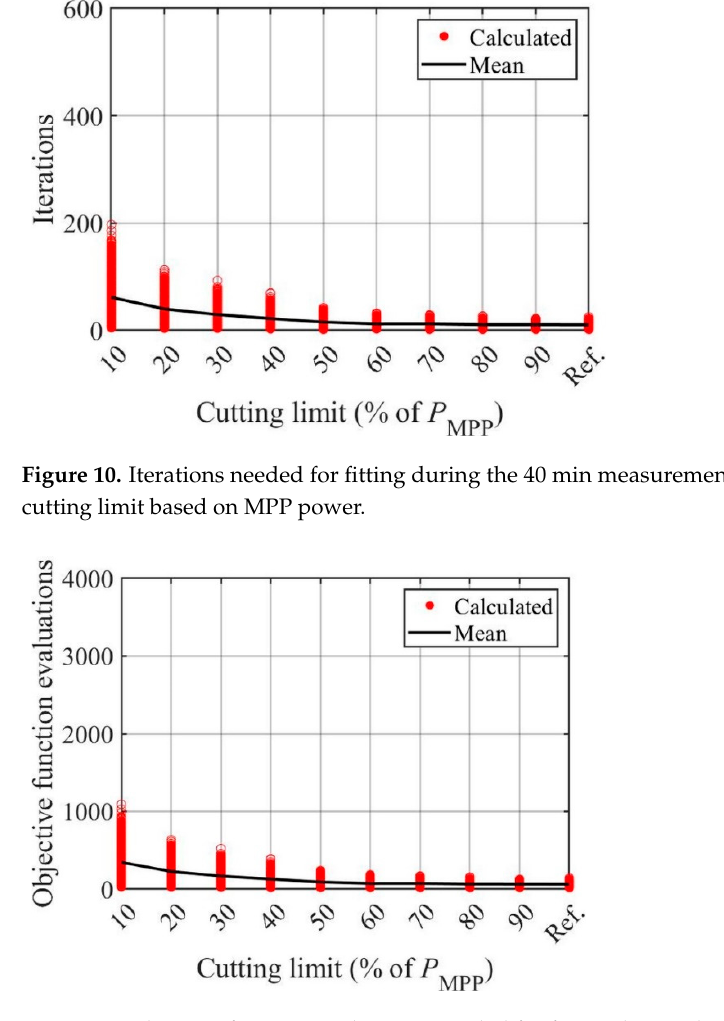
12 of 22 Figure 9. Fitted temperature values during the 40 min measurement period as a function of the cutting limit based on MPP power. Figure 10 shows the number of iterations used for I – U curve-wise fitting as a function of the cutting limit in terms of P MPP for the 40 min measurement period. The number of